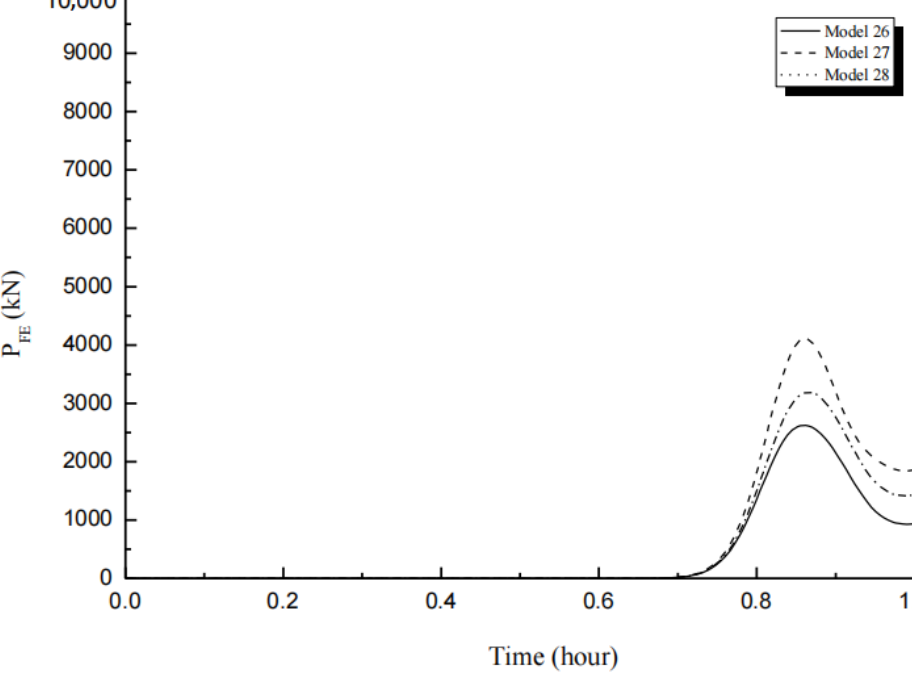
Figure 7. Axial strength versus time for model numbers 26–28.